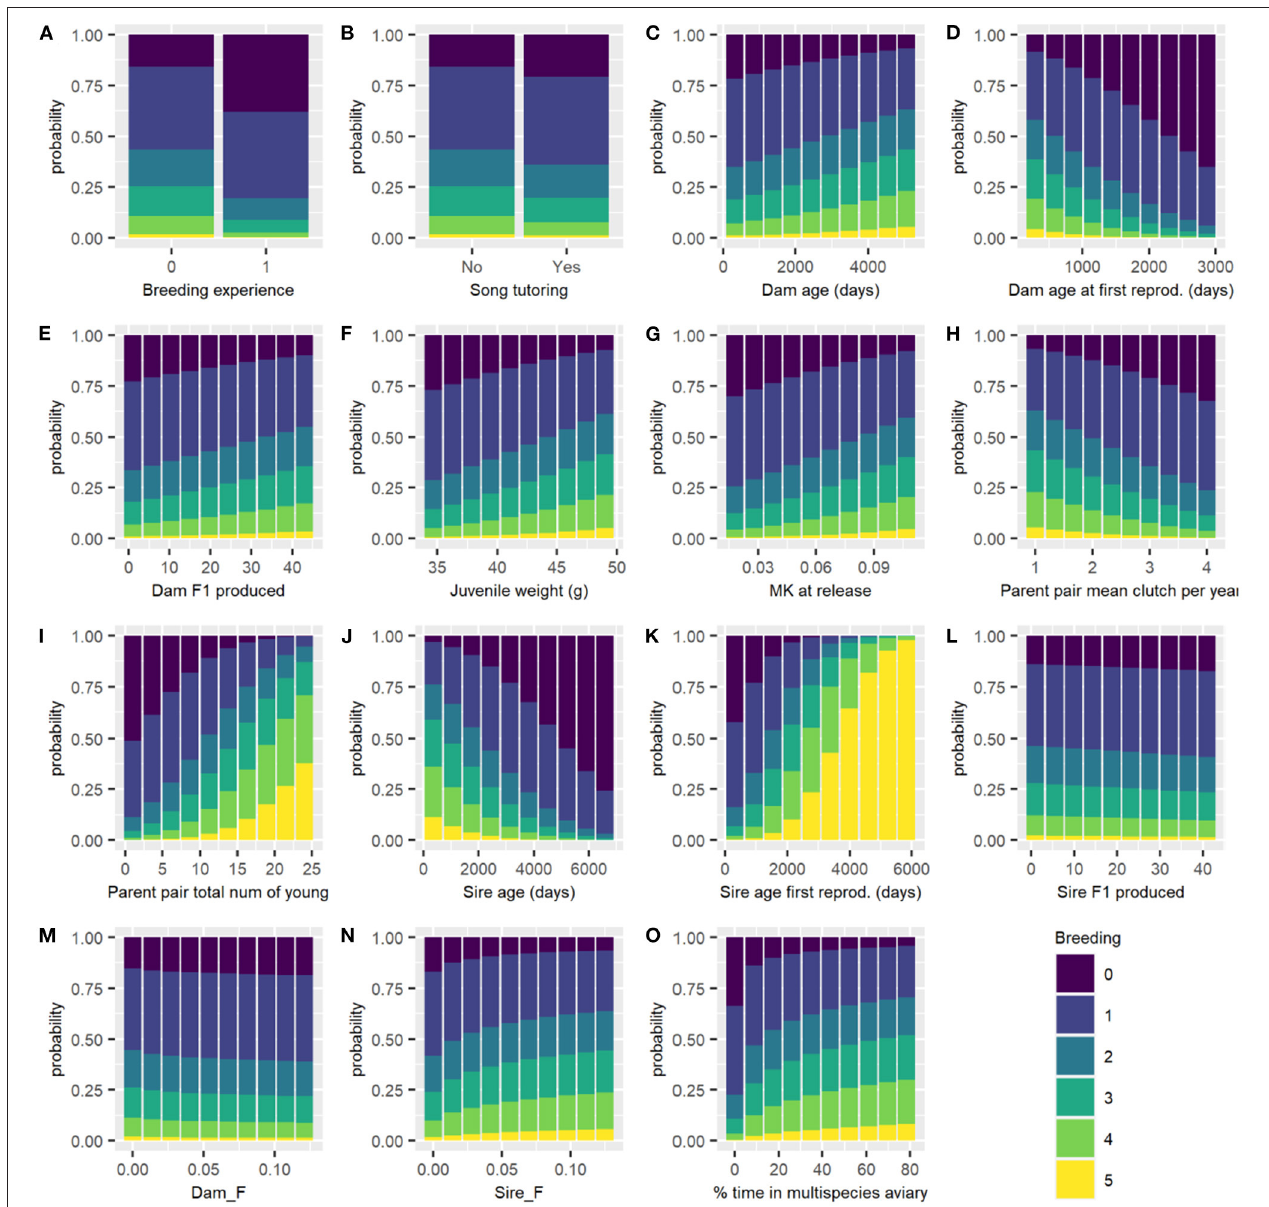
FIGURE 3 | Predicted probability of each breeding category for all males of each breeding category changing each variable in turn, with all other continuous variables held at their mean and categorical variables held at their reference level. Breeding categories: (0) not resighted after the start of the breeding season, (1) resighted but no nest, (2) nest, (3) incubation, (4) hatching, and (5) fledging success. (A) Breeding experience; (B) Song tutoring; (C) Dam age (days); (D) Dam age at first reproduction (days); (E) Dam F1 produced; (F) Juvenile weight (g); (G) MK at release; (H) Parent pair mean clutch per year; (I) Parent pair total number of young; (J) Sire age (days); (K) Sire age at first reproduction (days); (L) Sire F1 produced; (M) Dam F; (N) Sire F; and (O) percentage of time in multispecies